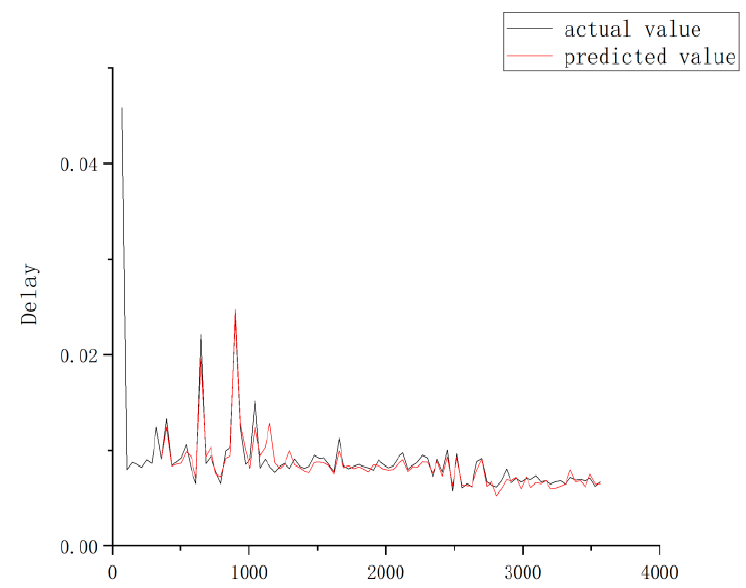
Figure 18. Comparison of the actual and predicted values.